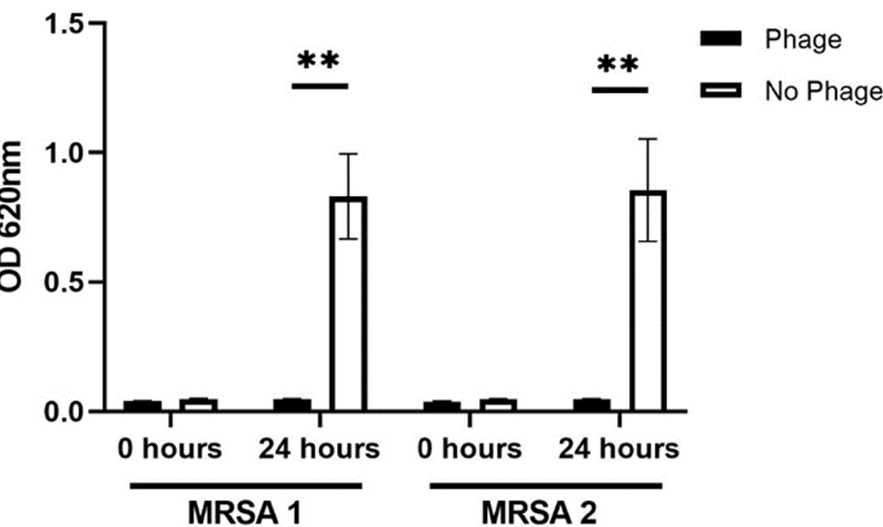
Figure 2. Bacteriophage growth inhibtion assays for the two different MRSA clinical isolates: Significant bacteriophage (Mallokai) induced growth inhibition was observed for both MRSA clinical isolates at 24 h (Wilcoxon test, ** p < 0.005). Experiment was conducted with six replicates and was reproduced in triplicate. Error bars are SD.